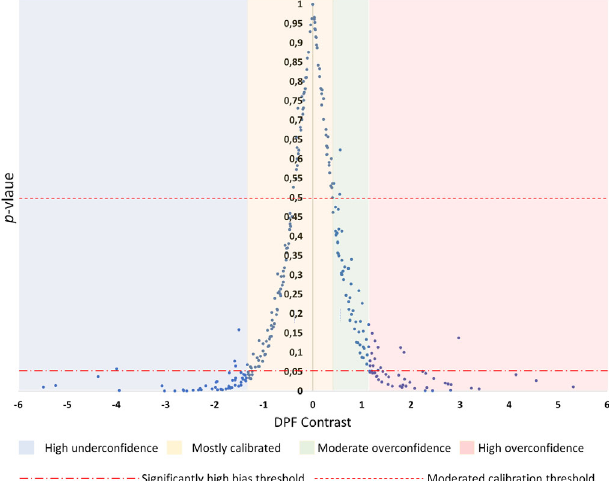
FIG. 1. p values associated with the DPF contrasts vs DPF contrasts in logit. DPF contrasts greater than þ 1 . 1 logit and less than − 1 . 5 logit are statistically significant (associated p value is less than 0.05) and are labeled as “ high overconfidence ” and “ high underconfidence, ” respectively. The interval [ − 1 . 5 , þ 1 . 1 ] logit is further demarcated using the FWHM ( p ¼ 0 . 5 ) points into three regions: [ − 1 . 5 , − 0 . 3 ] logit, [ − 0 . 3 ; þ 0 . 3 ] logit, and [ þ 0 . 3 ; þ 1 . 1 ] logit. We collapsed the two leftmost regions of the three into one region (shaded yellow) labeled “ mostly calibrated. ” The third region, shaded green, is labeled “ moderate over- confidence. ” In our analysis, when we refer to overconfidence, we mean the term to include both high and moderate over- confidence.